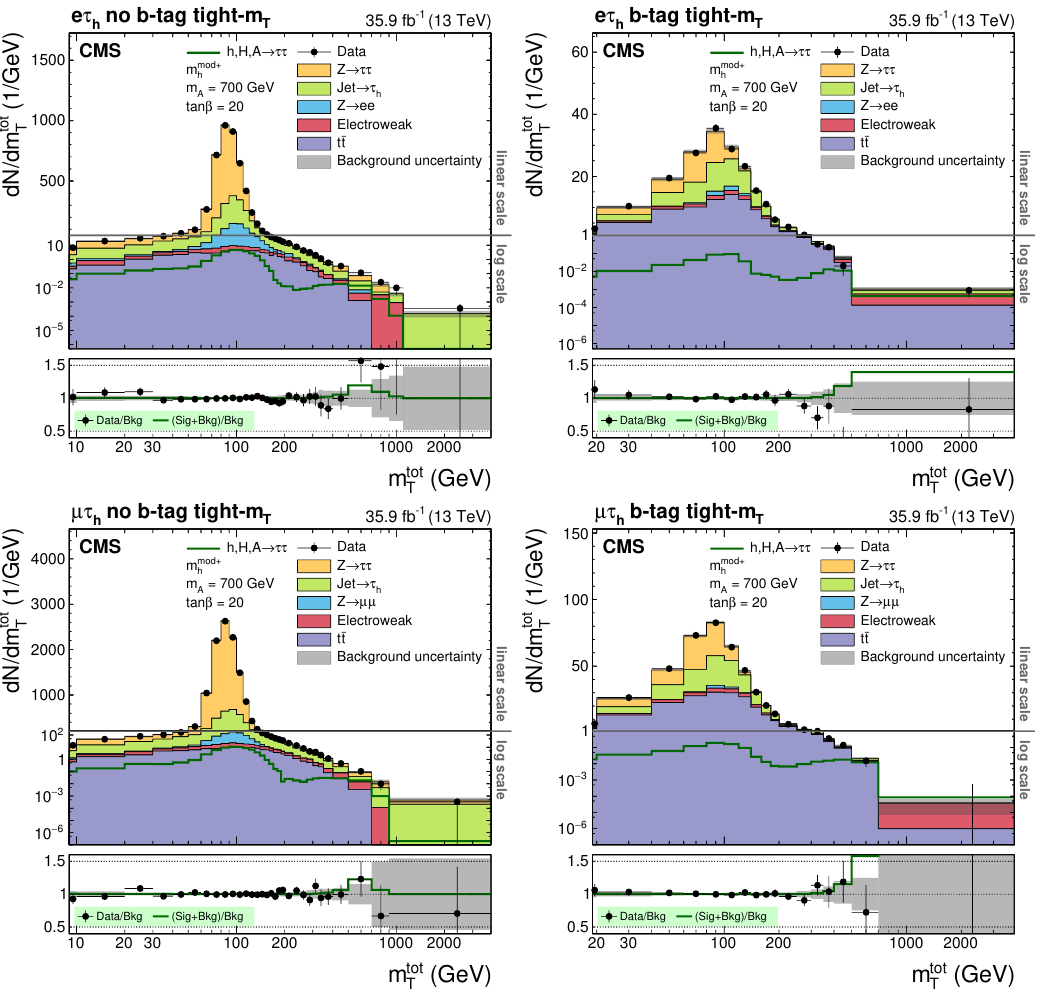
Figure 5 . Distribution of m tot in the global no b-tag (left) and b-tag (right) categories in the T e (cid:28) h (upper row) and (cid:22)(cid:28) h (lower row) (cid:12)nal states. In all cases the most sensitive tight- m T event subcategory is shown. The gray horizontal line in the upper panel of each sub(cid:12)gure indicates the change from logarithmic to linear scale on the vertical